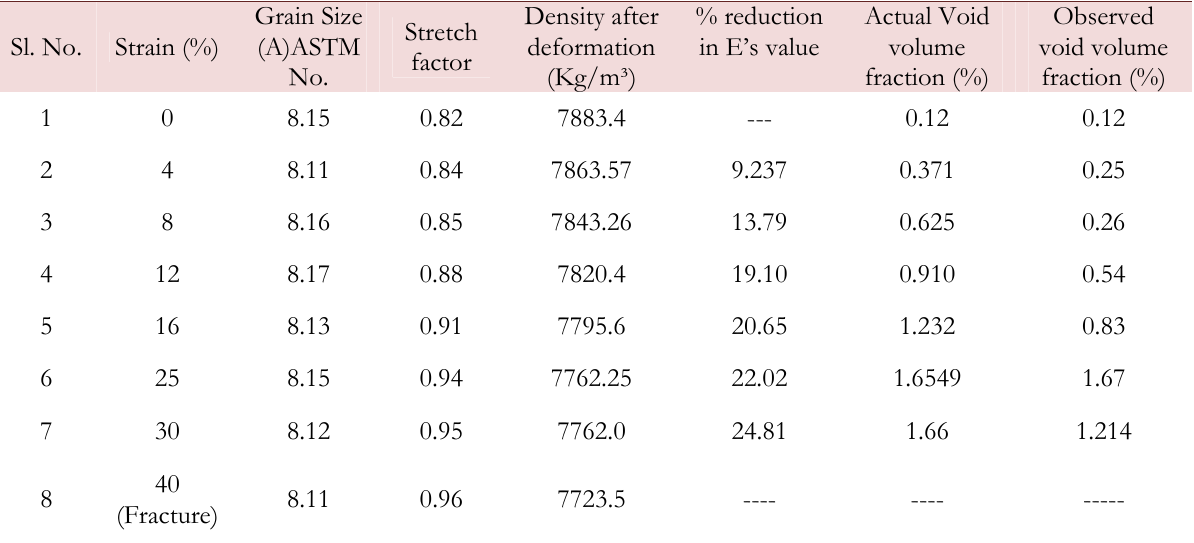
Table 1: Structural changes of specimen for various strains